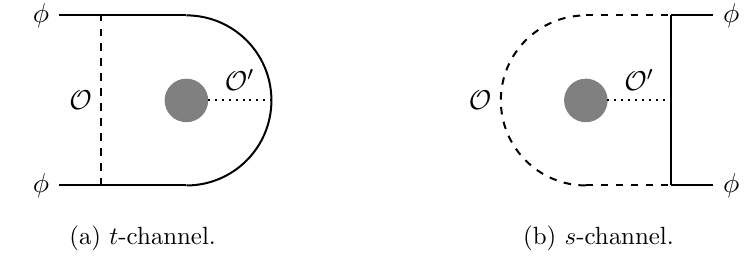
((cid:22) h ) (cid:2) a ( O 0 ) ((cid:22) h ). This [ (cid:30)(cid:30) ] n [ (cid:30)(cid:30) ] n